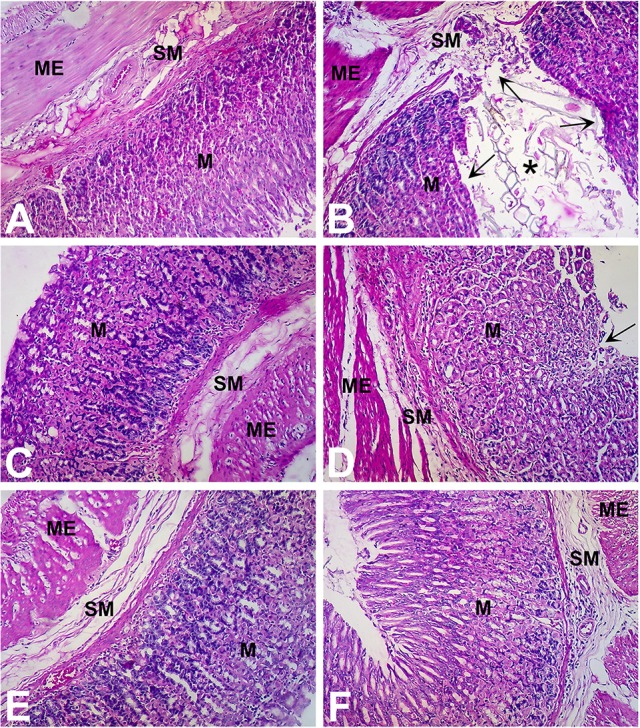
Gastroprotective effect of Ph.Cr extract in the aspirin induced ulcerogenesis in pylorus ligated rat model (H & E staining, 100 × original magnification) (n = 6 each). (A) Photomicrograph of a section of glandular portion of stomach from a vehicle treated control rat showing normal histological appearance of mucosa (M), submucosa (SM), and muscularis externa (ME). (B) Photomicrograph of a section of stomach glandular tissue from a rat treated with aspirin (200 mg/kg) showing disruption and erosion (arrows) of mucosa (M) which extend to the submucosa (SM) and muscularis externa (ME) along with necrotic debris visible in the lumen (asterisk) and base of the ulcer. Normal histoarchitecture of gastric mucosa (M), sub-mucosa (SM) and muscularis externa (ME) was observed in groups of rats treated with (C) positive control, ranitidine (50 mg/kg), (D) Ph.Cr extract at 100 mg/kg except for mild superficial shredding of surface mucosal epithelium (arrow), (E) Ph.Cr extract at 200 mg/kg, and (F) Ph.Cr extract at 400 mg/kg.